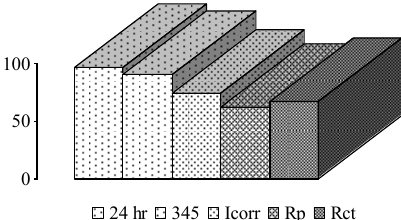
Figure 7. Comparison of IE between weight loss method and electrochemical measurements for SFCN extract.